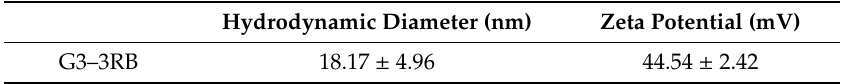
Table 1. Size and zeta potential of the G3–3RB–pyrro conjugate. Data presented as mean ± SD.